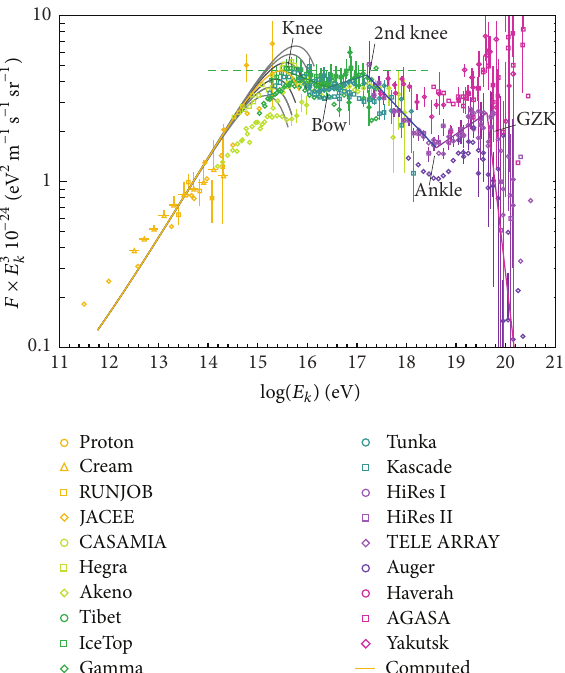
Figure 1: Flux of cosmic rays 𝐹 multiplied by 𝐸 𝑘3 is reproduced from published data (see text for references) without recalibration for unbiased assessment by the principle of least action. Coloring merely serves to emphasize various spectral regions. Comparison of data with the computed flux (orange line) via (5) indicates that most particles below 10 15.6 eV, known as the “knee,” have departed from sources in the expanding Universe, whereas above the “knee” the calculated flux from a stationary system with the characteristic 𝐸 −3 (green dashed line) via (3) implies that recorded particles originate from sources in the nearby nonexpanding part of the Universe. The close match of computed flux with data at the “knee” provides an estimate for the radius 𝑟 𝑜 ≈ 1.3 Mpc (with ± 10% uncertainty shown by grey lines) of the nonexpanding part of the Universe. Above the knee the flux decreases as 𝐸 −3.1 because protons will slow down first by producing photons and eventually neutrinos (green line). Then, above 10 17.2 eV, known as the “2nd knee,” the flux decreases as 𝐸 −3.3 because protons will slow down more effectively producing pairs of electrons and positrons (blue line), and then above 10 19.6 eV the flux decreases approximately as 𝐸 −6 , known as the GZK cutoff, by the even more effective pion production (purple line). The decelerated protons by various mechanisms will return to lower energies. The reflux from the meson production (violet line) will give rise to the “ankle” at about 10 18.6 eV above which the flux decreases as 𝐸 −2.8 and likewise the reflux from the lepton production (dark green) will give rise to the “bow” at about 10 16.4 eV above which the flux decreases as 𝐸 −2.9 .